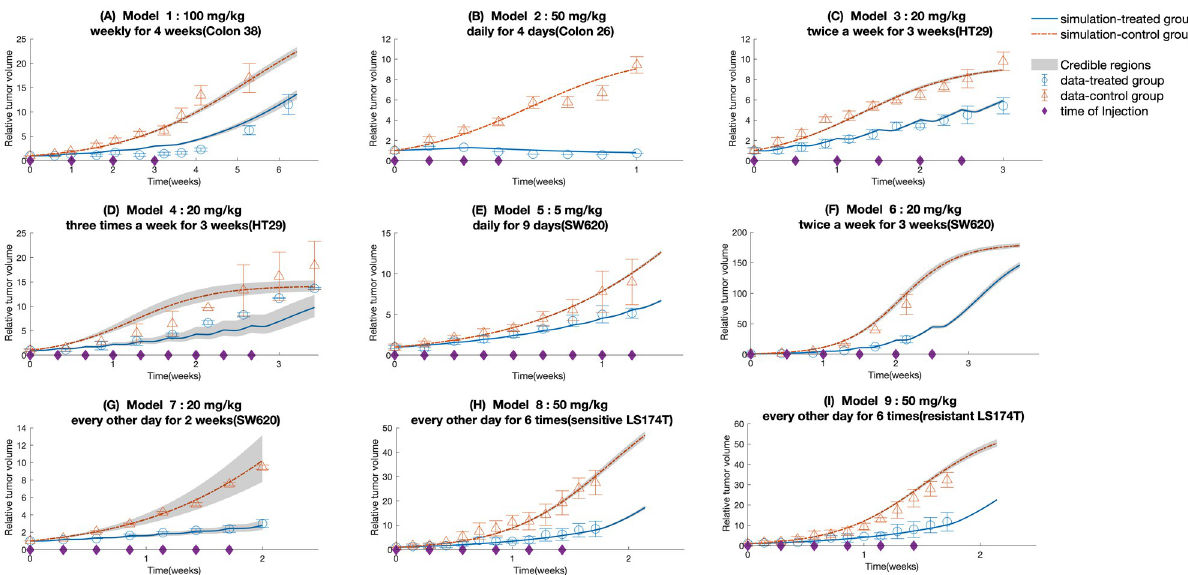
Fig 4. Time-dependent outputs of the 9 TGI model using parameter estimates shown in Table 4. Red line represents the time course of the control group; blue line represents the time course of colon tumor growth treated with corresponding dosage regimens shown in Table 3; triangle, literature data for the control group; circle, literature data for the treated group; error bar, standard errors; asterisk on x-axis represents injection time. The shaded areas in each panel represent the 0.7 credible